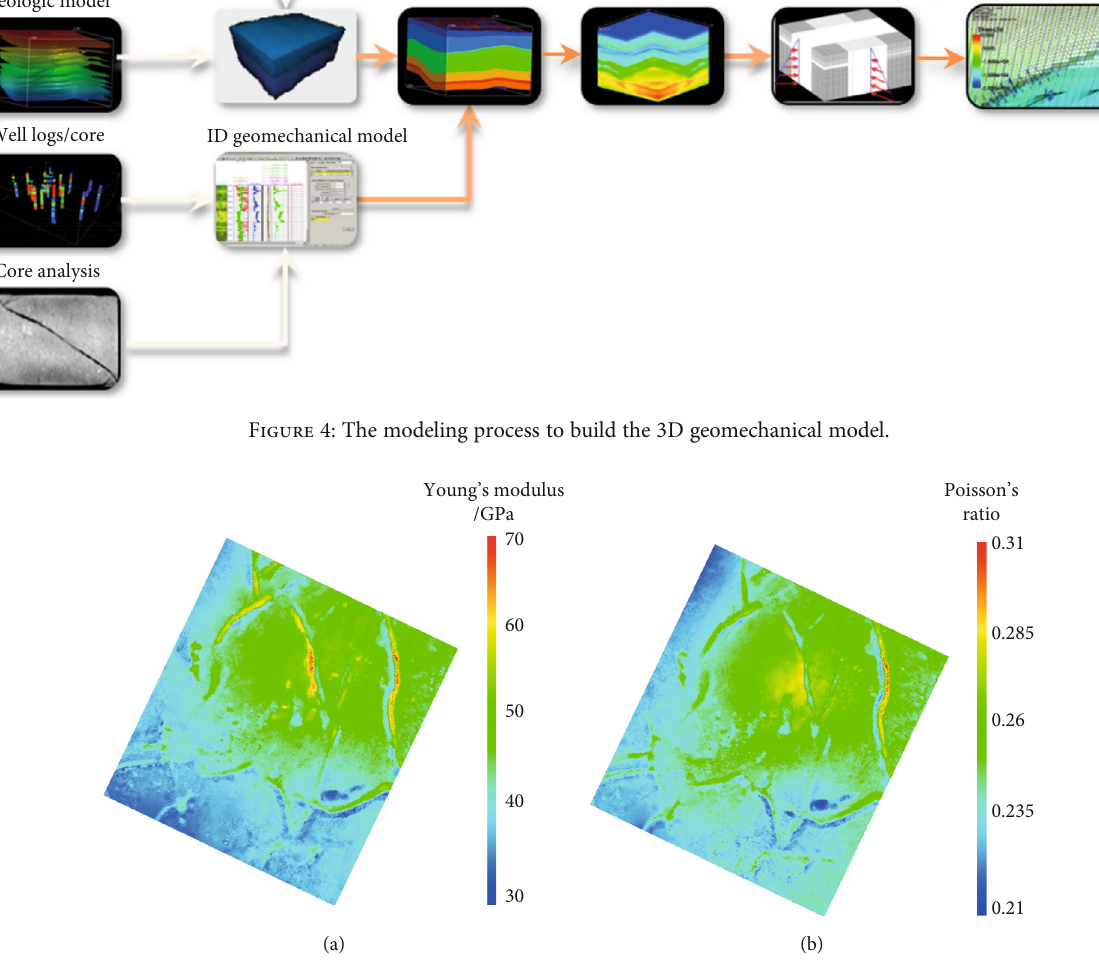
Figure 5: The 3D anisotropic mechanical properties model: (a) Young ’ s modulus; (b) Poisson ’ s